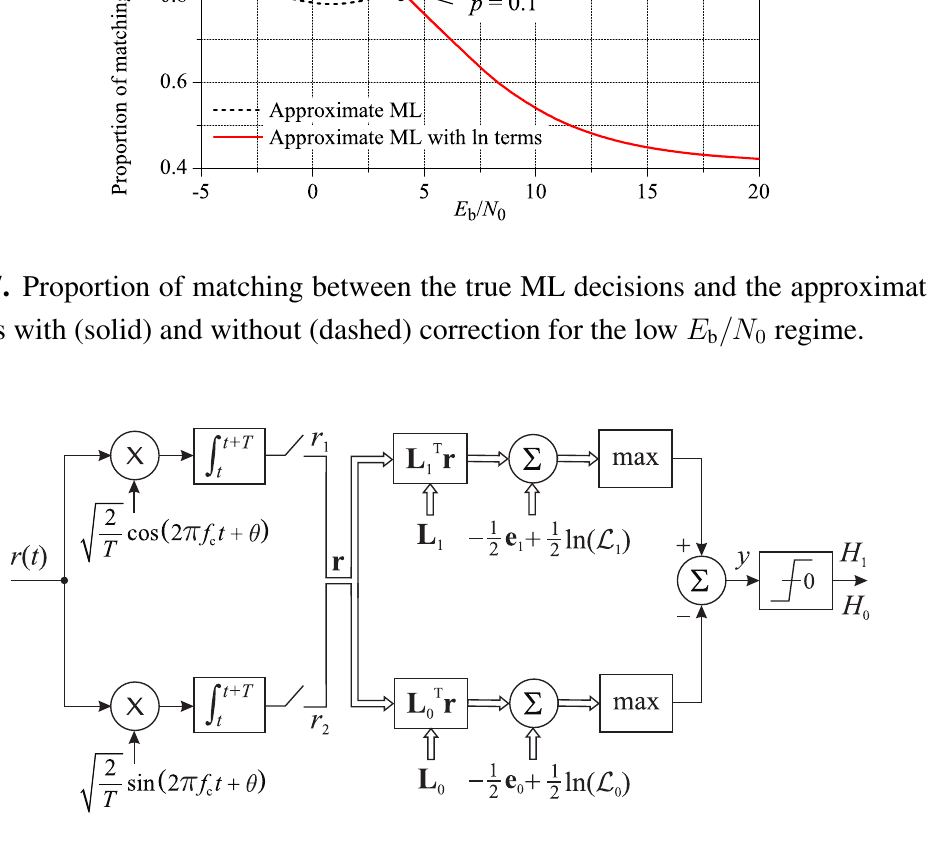
Figure 8. Suboptimum receiver with improved performance in low